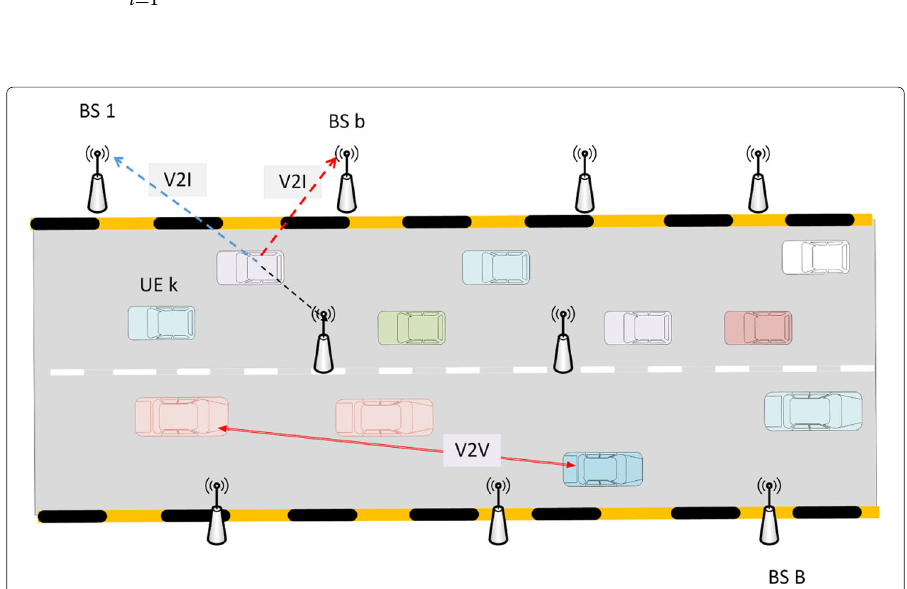
Fig. 1 V2I and V2V communication system with B BSs. A V2V/V2I example; a UE communicating with three mMIMO BSs and direct communication between a pair of